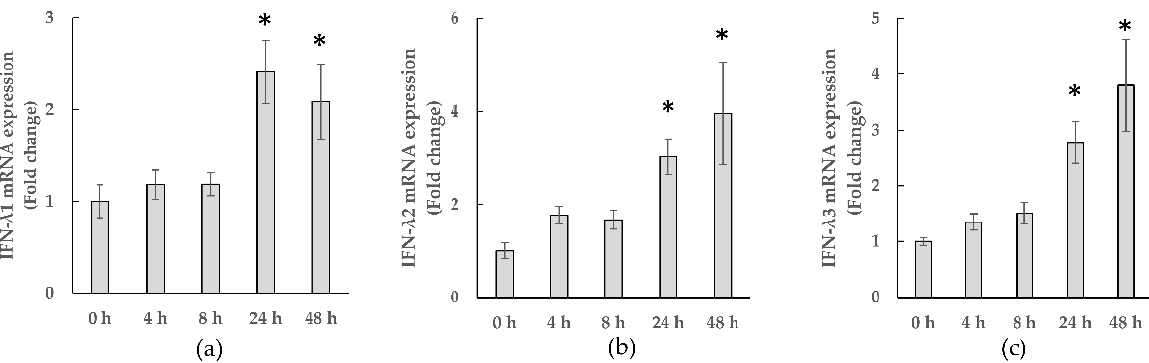
Figure 2. Gene expressions of ( a ) IFN- λ 1 , ( b ) IFN- λ 2 , and ( c ) IFN- λ 3 . The values are shown as means ± SE. Asterisks indicate a significant difference when compared to 0 h ( p -value < 0.05). Data from six independent experiments are shown.